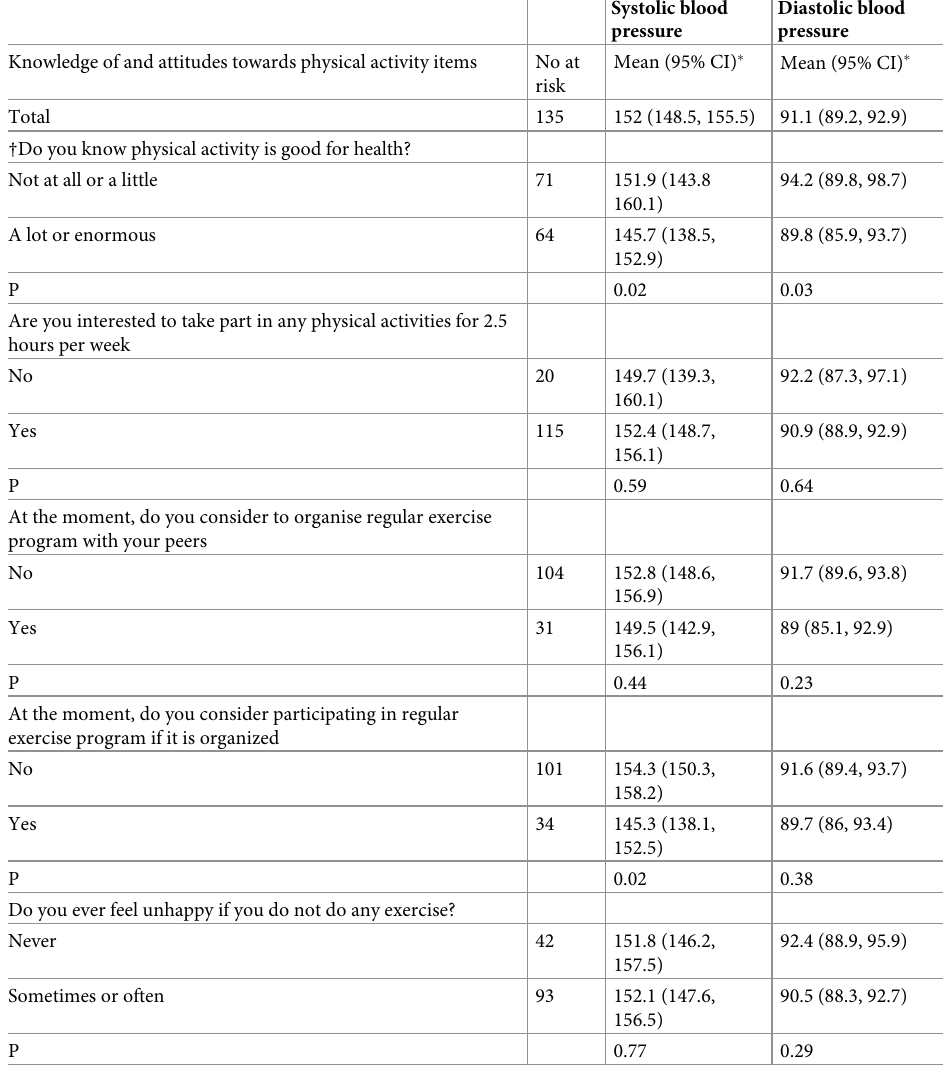
� Estimated mean with 95% confidence interval (CI) (unadjusted model). † estimated mean with 95% confidence interval (CI) adjusted for age, gender, education levels and